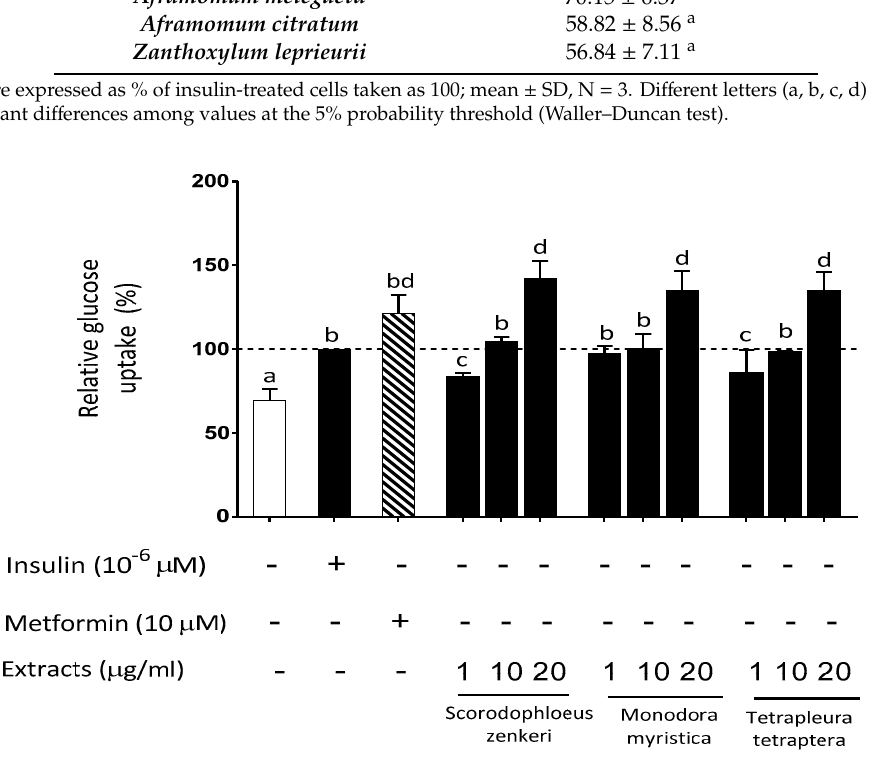
Figure 6. Effect of spice extracts on glucose uptake. Concentration-dependent (1–20 μ g/mL) stimulation of glucose uptake in HepG2 cells with Scorodophloeus zenkeri , Monodora myristica , Tetrapleura tetraptera , and metformin (10 μ M = 1.3 μ g/mL). Incubation time: 24 h. Data are expressed as % of insulin treatment taken as 100; mean ± SD, N = 4. Different letters (a, b, c, d) refer to significant differences among values at the 5% probability threshold (Waller–Duncan test). Table 4. Effect of plant extracts on oxidative stress modulation of glucose uptake in HepG2 cells.